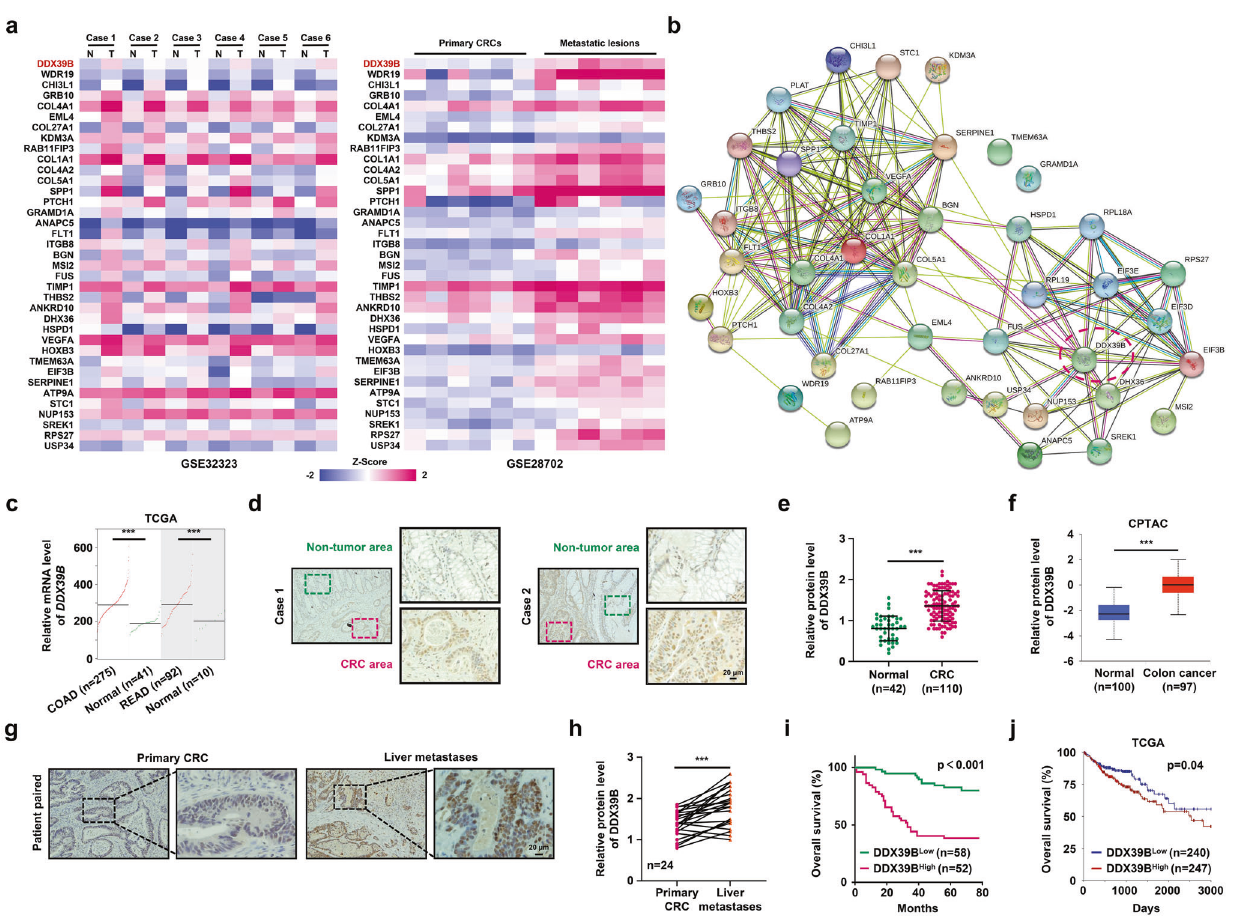
Fig. 1 Upregulation of DDX39B correlates with aggressive phenotypes and poor prognosis in human CRC. A total of 37 up-regulated genes both in primary and metastatic CRC tumors were displayed as a heatmap ( a ) and by STRING network ( b ) analysis. N normal tissues; T: CRC tumors. c DDX39B transcripts in colon adenocarcinoma (COAD), rectal adenocarcinoma (READ) and normal tissues from the TCGA database were analyzed through an online tool (http://gepia2.cancer-pku.cn/). d , e DDX39B protein levels in a microarray of CRC and normal